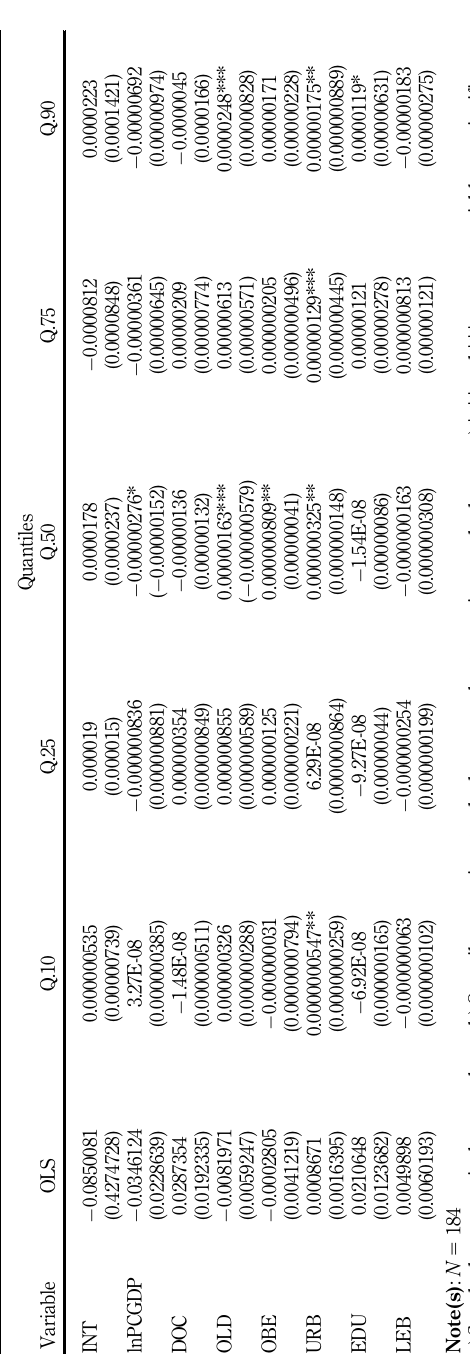
Table 1. Results of OLS